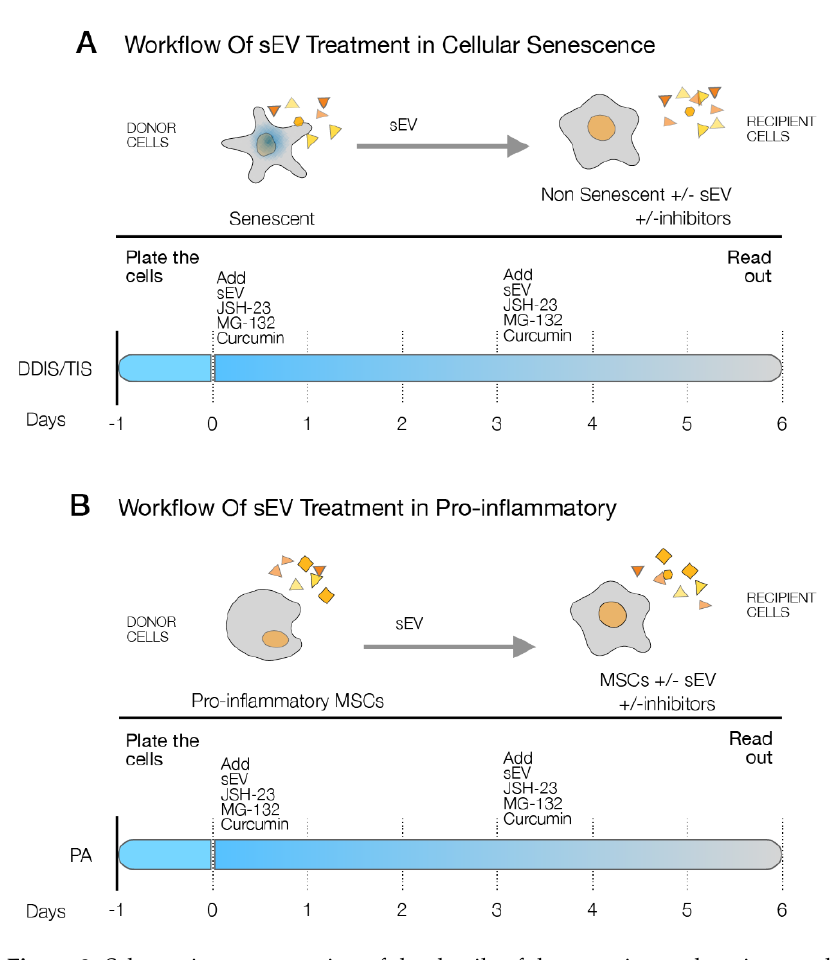
Figure 8. Schematic representation of the details of the experimental settings to the p65 pathway involved in the cellular senescence and proinflammatory paracrine transmission by small extracellular vesicles (sEV). ( A ) Proliferative mesenchymal stem cells (MSCs) (Non-Se) were treated with sEV from Se (DNA damage-induced senescence (DDIS) and therapy-induced senescence (TIS)) and the small inhibitors (JSH-23, MG-132 and curcumin) for six days. ( B ) MSCs were treated with sEV from proinflammatory-activated MSCs (tumor necrosis factor alpha (TNF- α )) and JSH-23, MG-132 and curcumin for six days.